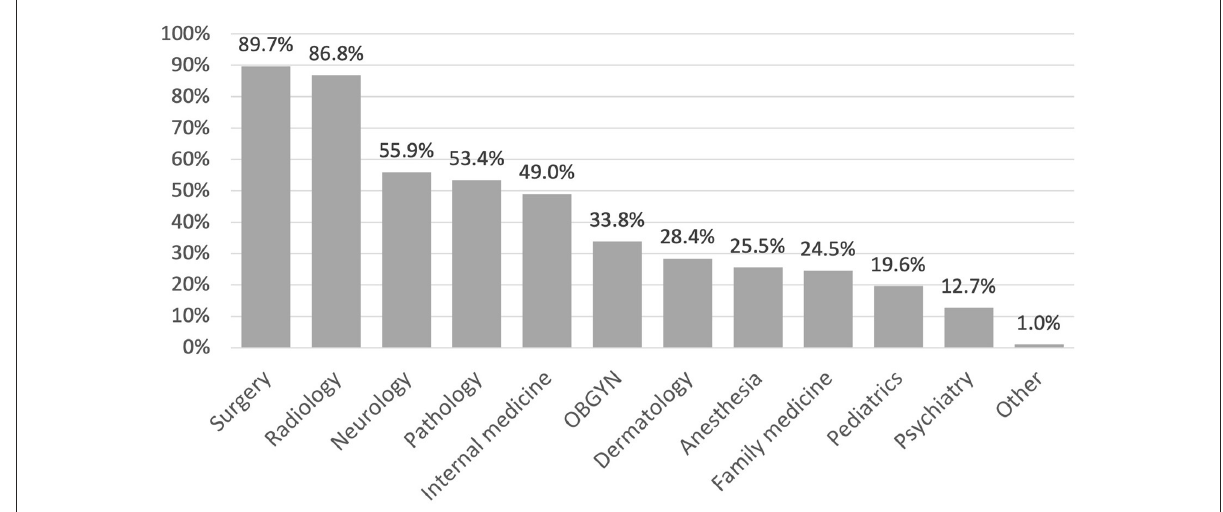
FIGURE1 The current use of AI by medical specialty as perceived by medical